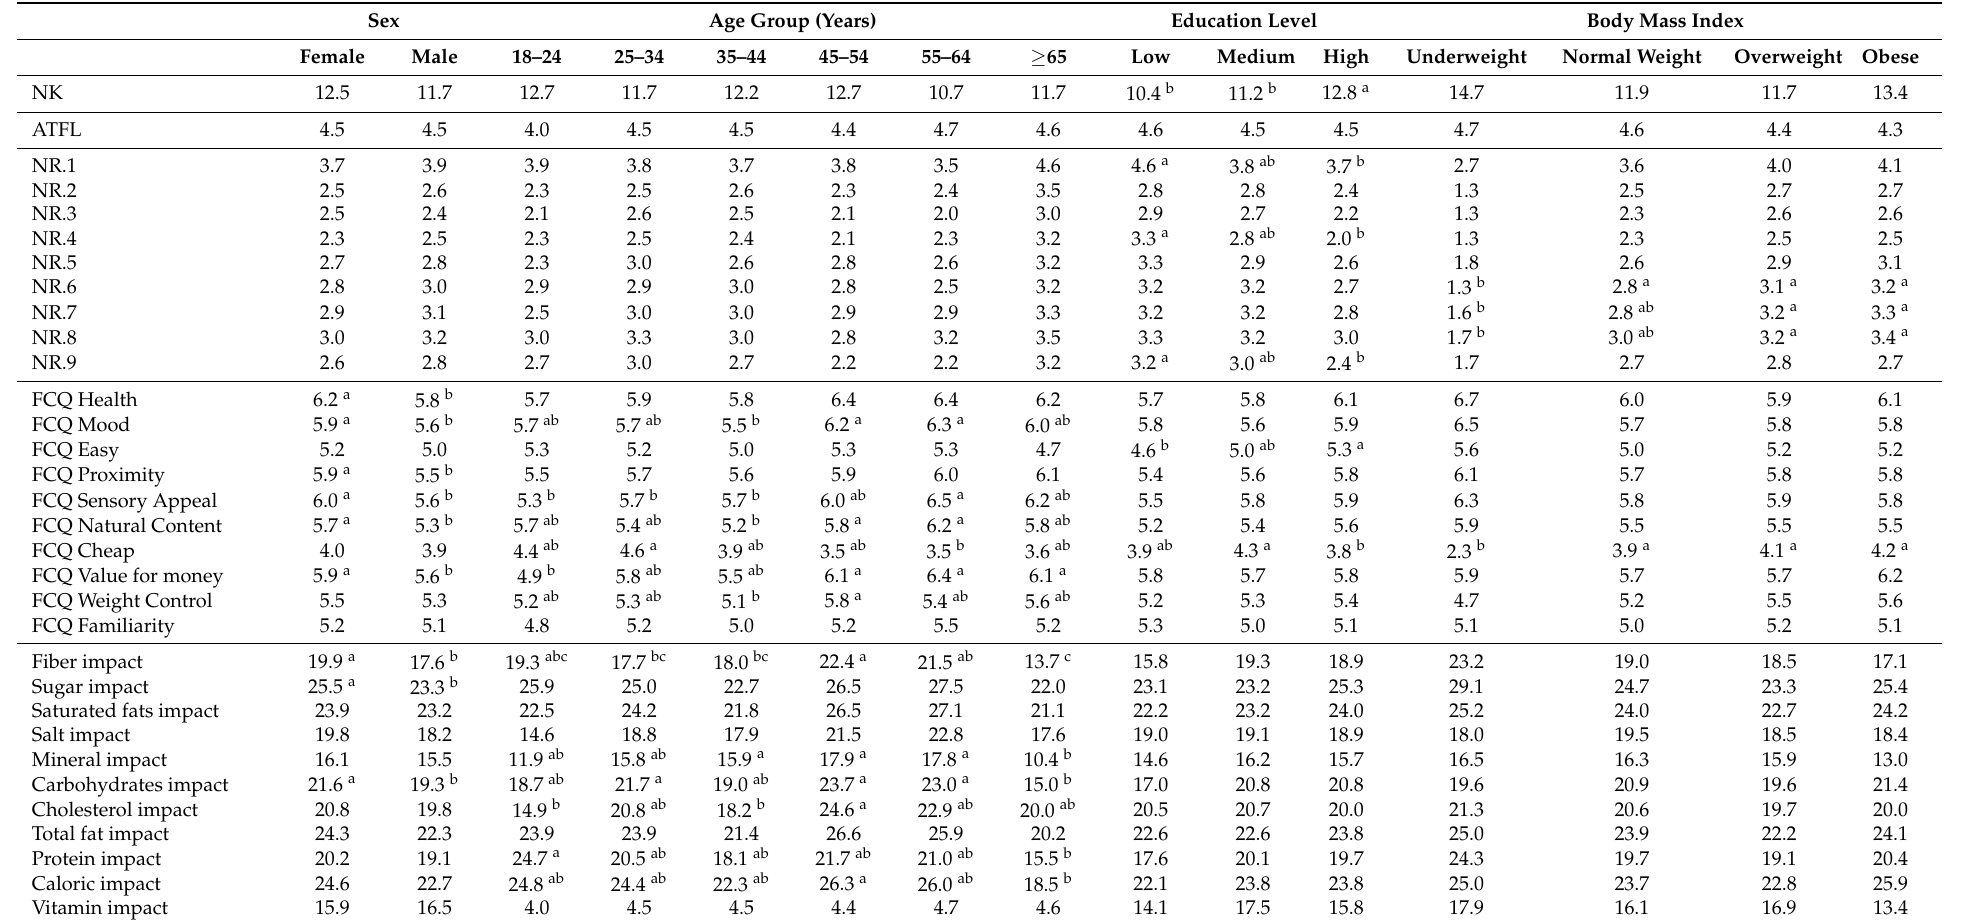
Table 3. Mean values for each item or construct of the questionnaire, sociodemographic level, BMI, and label reading percentages for the participants who followed a